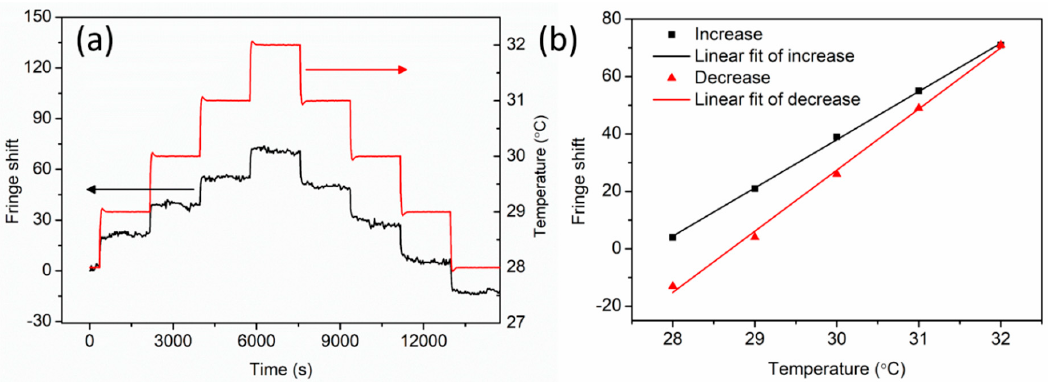
Figure 7. ( a ) Fringe and temperature variation as a function of time and ( b ) linear fit of fringe shift versus temperature (increase and decrease) right after PC mPOF annealing at 125 °C for 36 h.